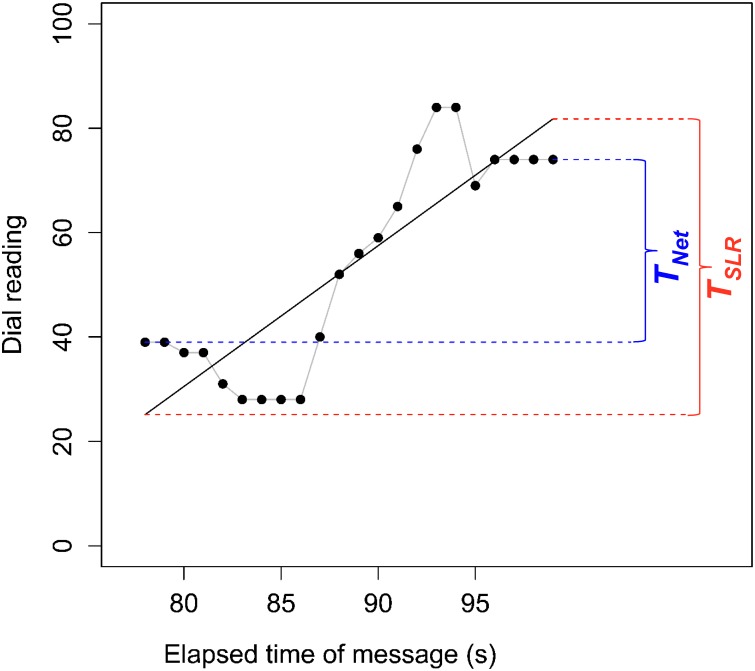
Illustration of how TNet and TSLR were calculated.Points represent the dial reading at each second for a participant during the Characters in action segment of the Victim—to—hero message with Certainty language. Gray line traces points. Solid black line denotes simple linear regression of dial reading against elapsed time of message. TNet was calculated by subtracting the participant’s initial dial reading from their final dial reading within a segment. TSLR was calculated by multiplying the estimated change in dial reading per second (regression slope) by the duration of the segment in seconds.